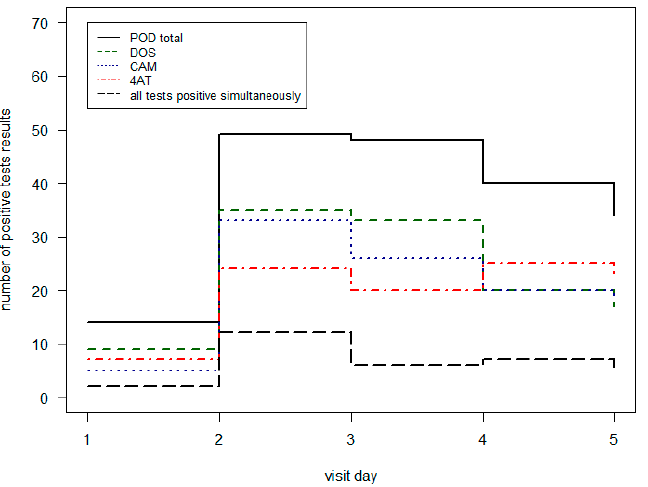
Figure 3. Comparison of positive POD tests on normal ward per visit day. Table 6. Comparison of positive POD tests on normal ward.